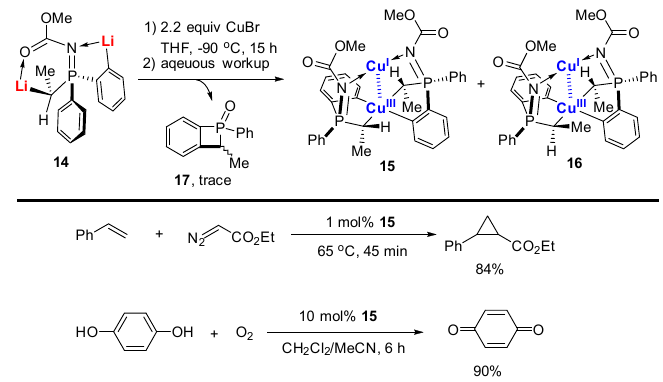
Scheme 4. Mixed-valent bimetallic Cu(I)/Cu(III) compounds [62].